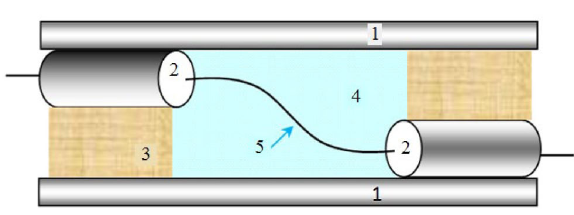
Fig. 4 Schematic diagram of the sensor with S-shaped bending and packaged (1: package housing; 2: capillary steel tube; 3: protective sleeve; 4: heat conducting oil; and 5: dislocation